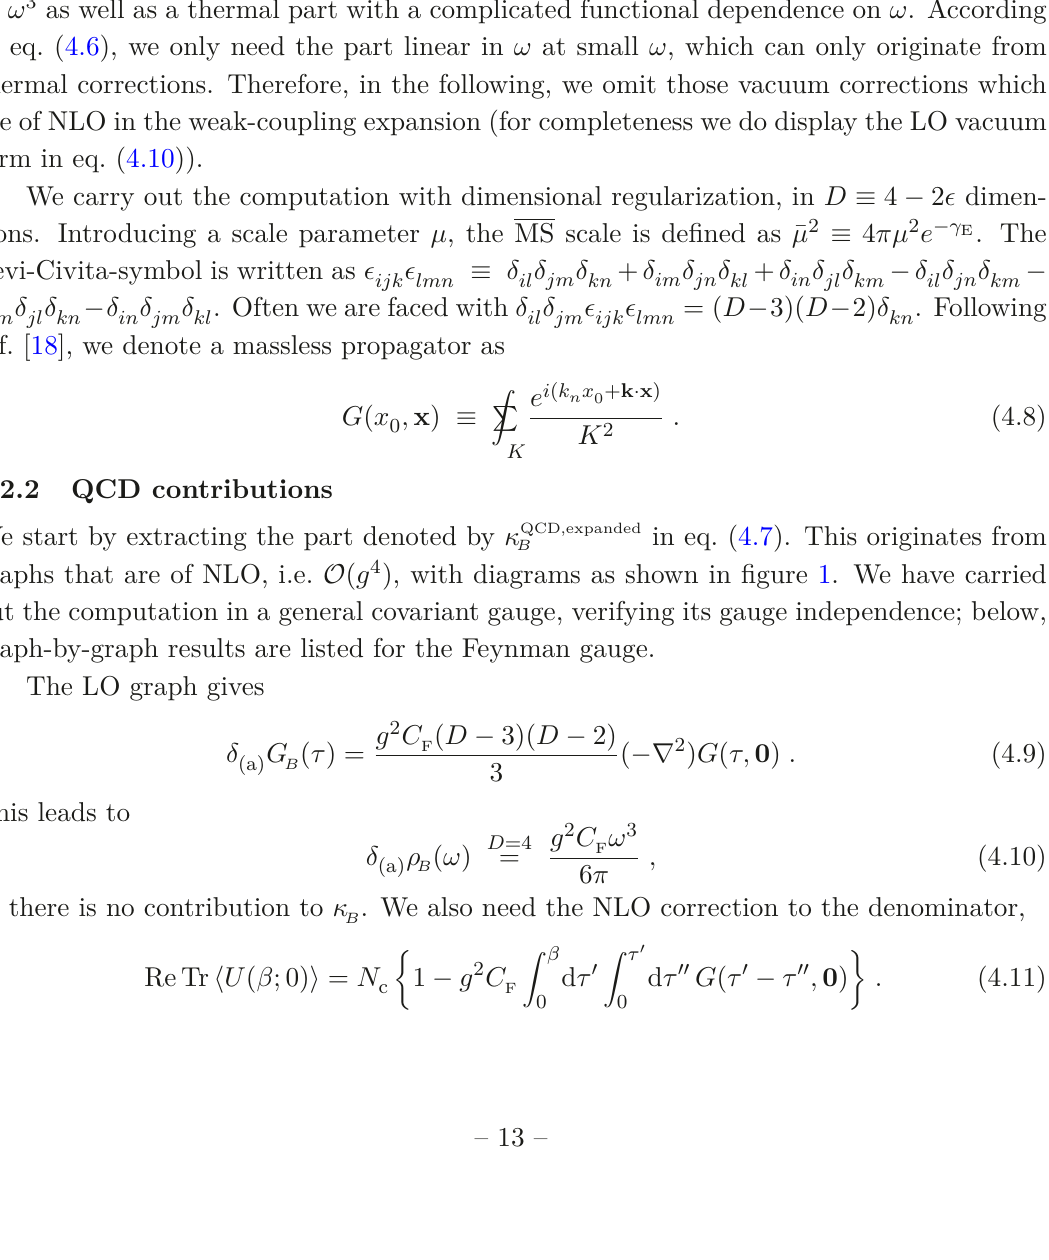
Figure 1 . The LO and NLO graphs contributing to the colour-magnetic correlator, G eq. (3.39). The big circle denotes a Polyakov loop; the small dots colour-magnetic field strengths; and the grey blob the 1-loop gauge field